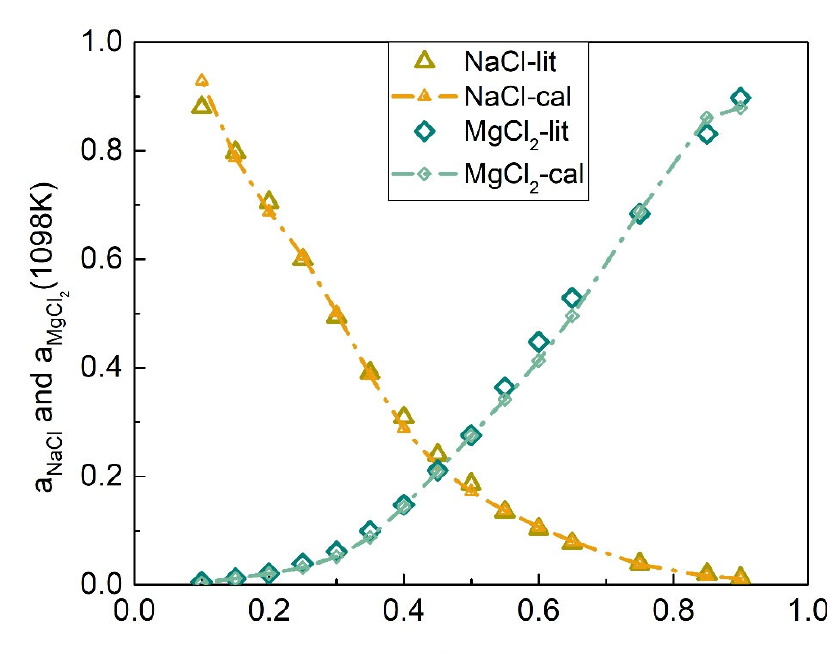
Figure 13. Calculated activity coefficients of each element of the NaCl ‐ MgCl 2 system (1098 K).